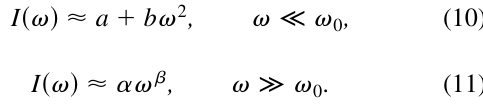
FIG. 6. (Color) Autocorrelation function (top) and completed intensity spectrum (bottom) for 3.2 nC electron bunches at moderate compression. The solid curve (bottom) is the asymp- totic intensity spectrum at high frequencies. Data points with negative values of the intensity were set to zero. The unknown parameters from Eq. (11) were determined from a least-squares fit with data points corresponding to frequencies higher than . A Golay detector was used for these measurements. 2 ! 0